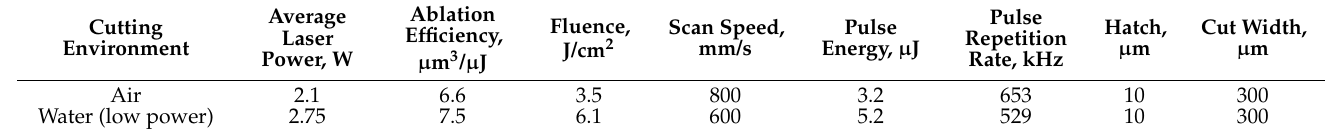
Table 1. Optimised glass cutting parameters (low-laser-power cutting